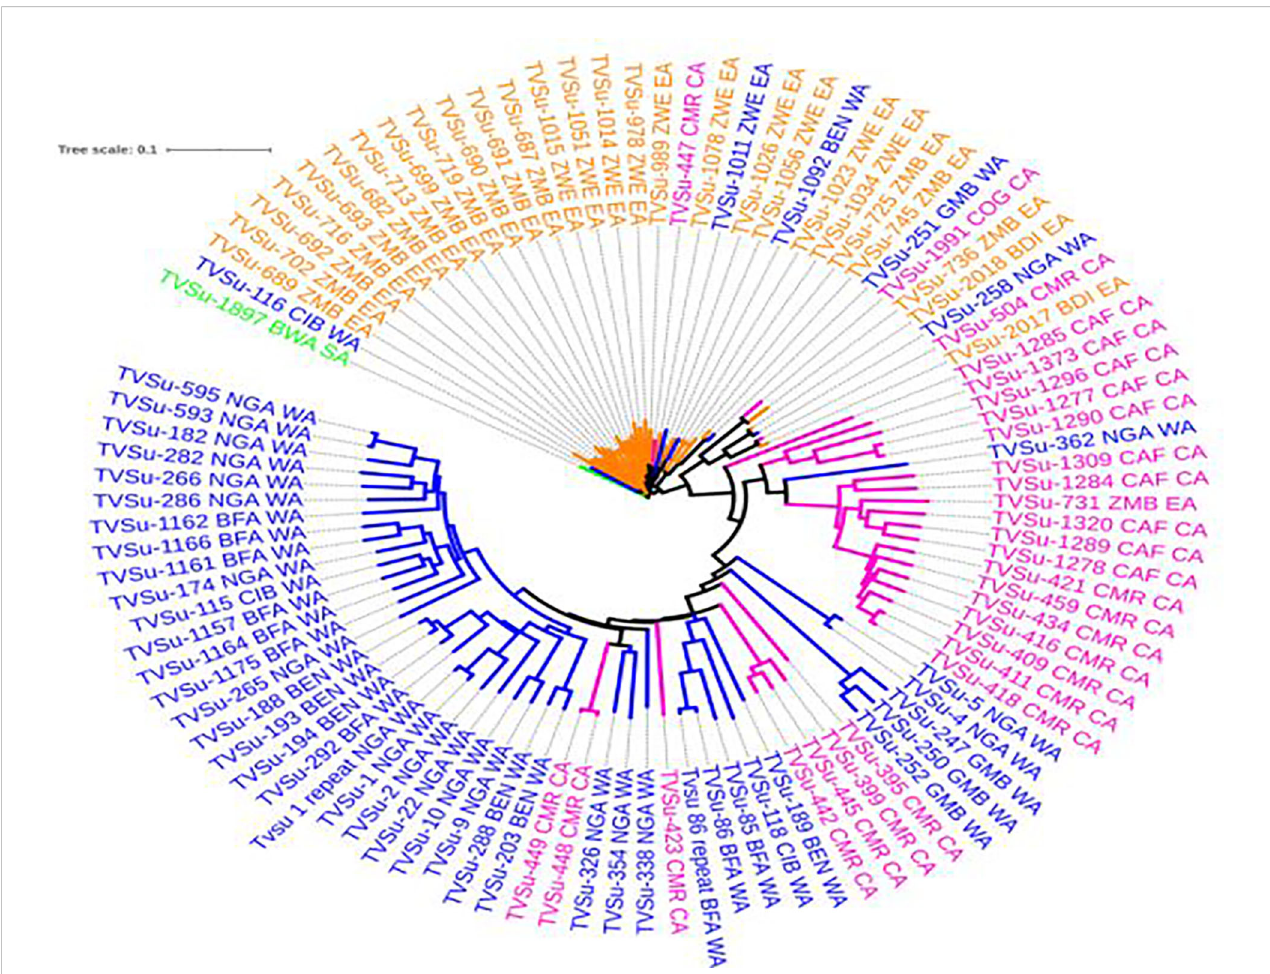
FIGURE 3 Phylogenetic relationship among Bambara groundnut accessions from 12 countries. Interactive tree of Life (ITOL) Letunic and Bork (2016) Nucleic Acids Res .